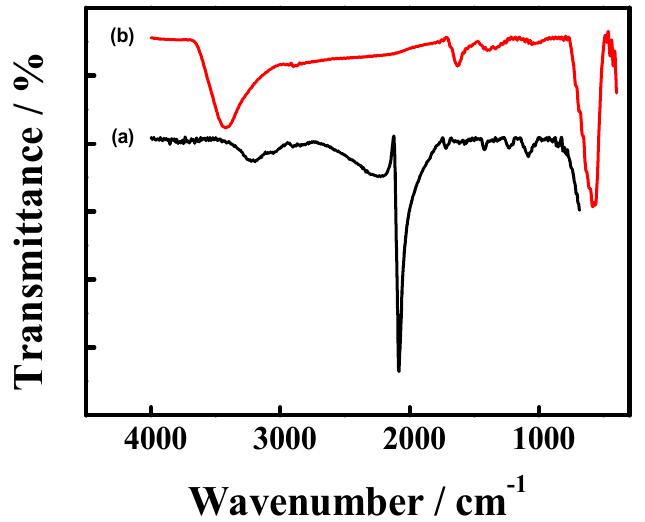
Figure 6. (a) ATR − FTIR spectrum of PBNC film deposited onto the electrode surface. (b) FTIR spectrum of magnetite nanoparticles.